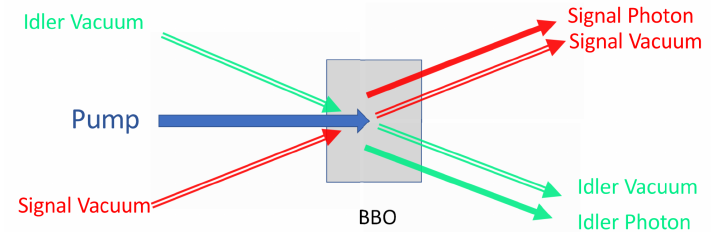
Figure 5. Signal- (idler-) photons are created by the mixing in the BBO crystal of the pump field with the vacuum field in the idler (signal) mode, as described by Equations (2) and (3). The signal (idler) field emerging from the crystal is the sum of the vacuum field in the signal (idler) mode and the signal (idler) field resulting from the nonlinear mixing process described by the Hamiltonian